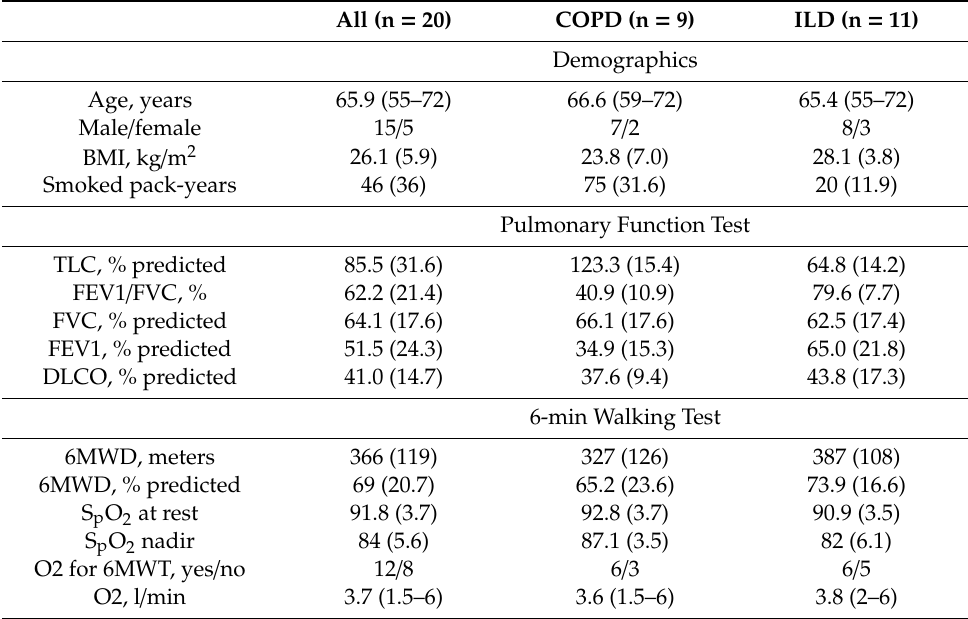
Table 2. Baseline characteristics of participating subjects in the patient group (phase II of study). Values shown represent mean (standard deviation) or median (range) .